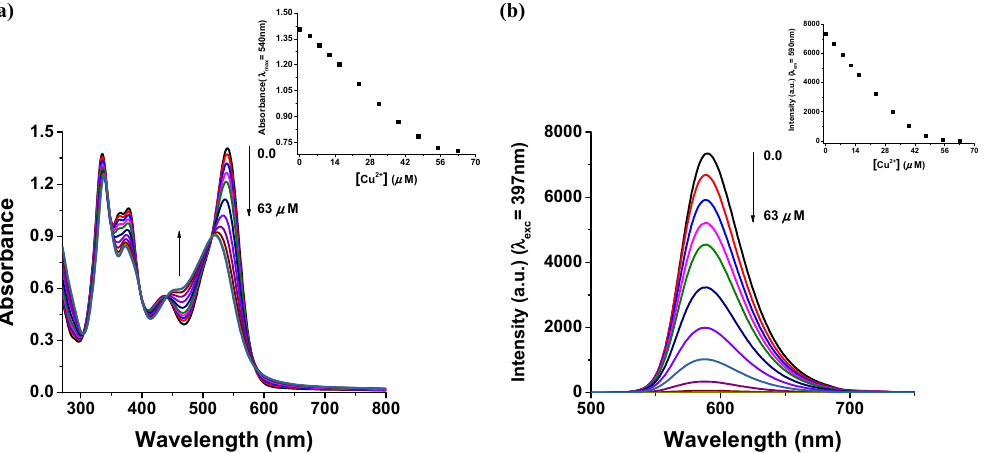
Figure 2. Optical absorption ( a ) and fl uorescence ( b ) titration curves of 2 (40 µM solution in MeCN; λ exc = 397 nm) with the addition an of aqueous solution of Cu(NO 3 ) 2 . The concentration of Cu 2+ added varied from 0 to 63 µM. Arrows indicate optical absorption and fl uorescence changes upon addition of Cu 2+ . Insets: Variation in the absorbance at λ max = 540 nm and fl uorescence at λ em = 590 nm as a function of the concentration of Cu 2+ added.